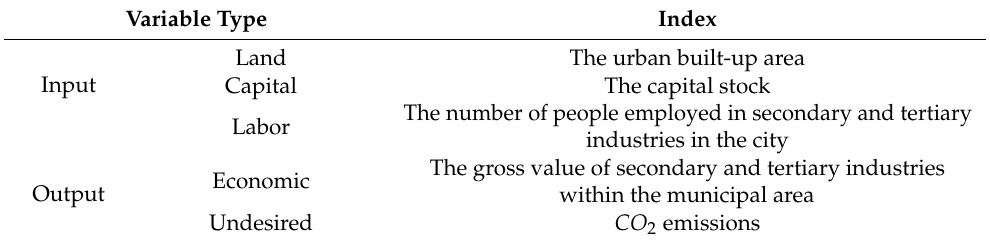
Table 2. Input-output index table.